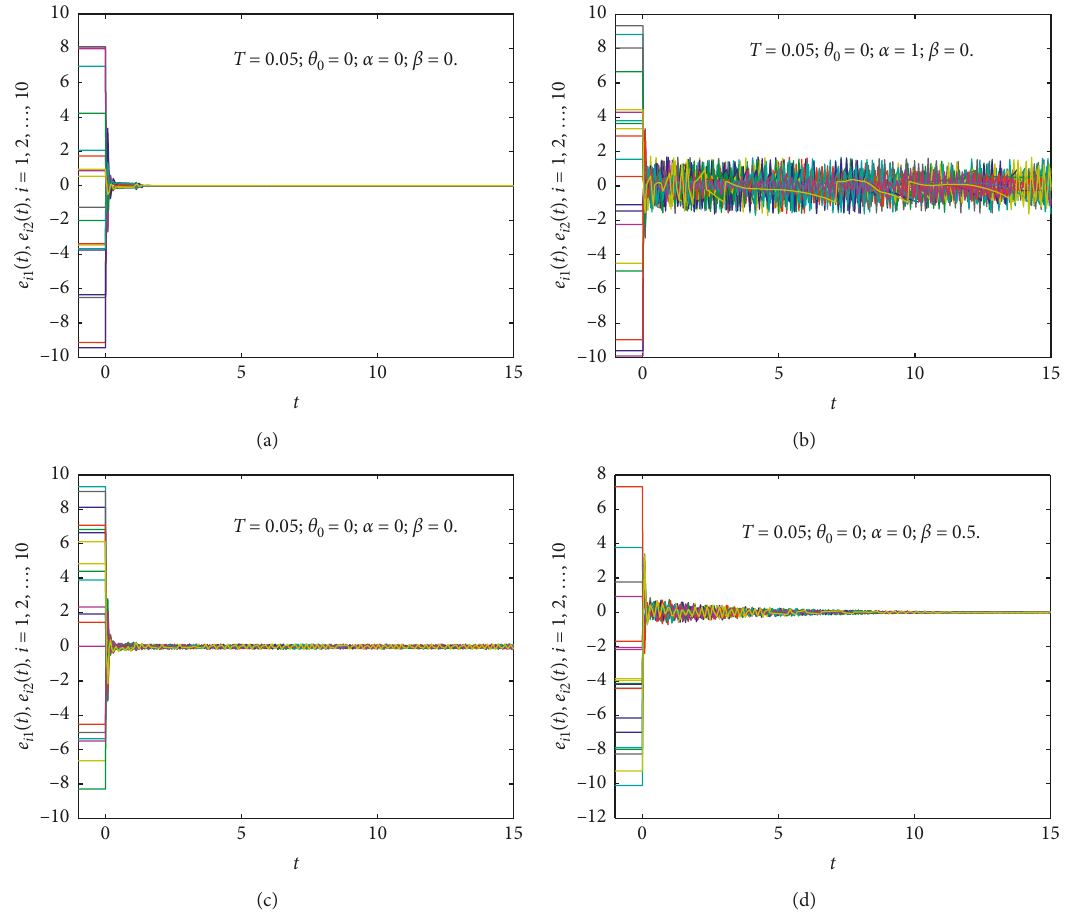
Figure 13: Time evolution of synchronization errors e